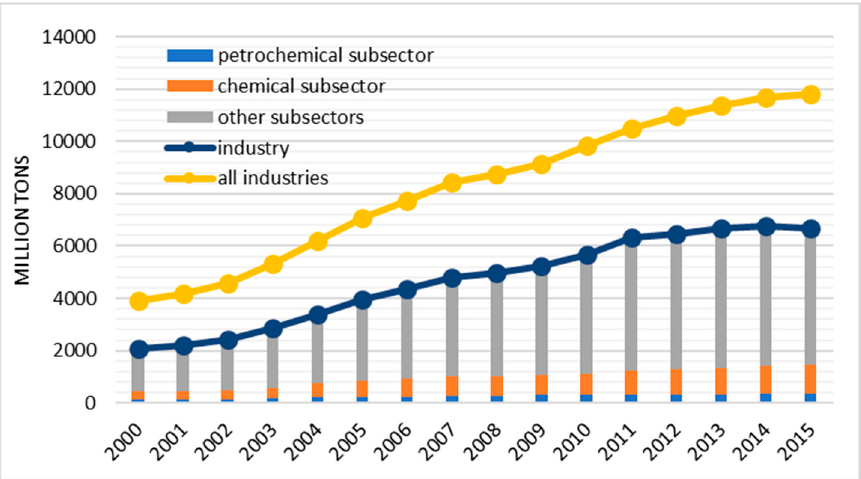
Figure 4. Historical CO 2 emissions and proportions. Total amount of CO 2 emission is over 6 billion tons in the petrochemical and chemical industry, a proportion of nearly 60% of the whole industry emissions. Source: China Statistical Yearbook (2000–2016), China Energy Statistical Year book (2000– 2016), National Standard GB/T2589-2008, 2015 Energy Statistics [31–34].